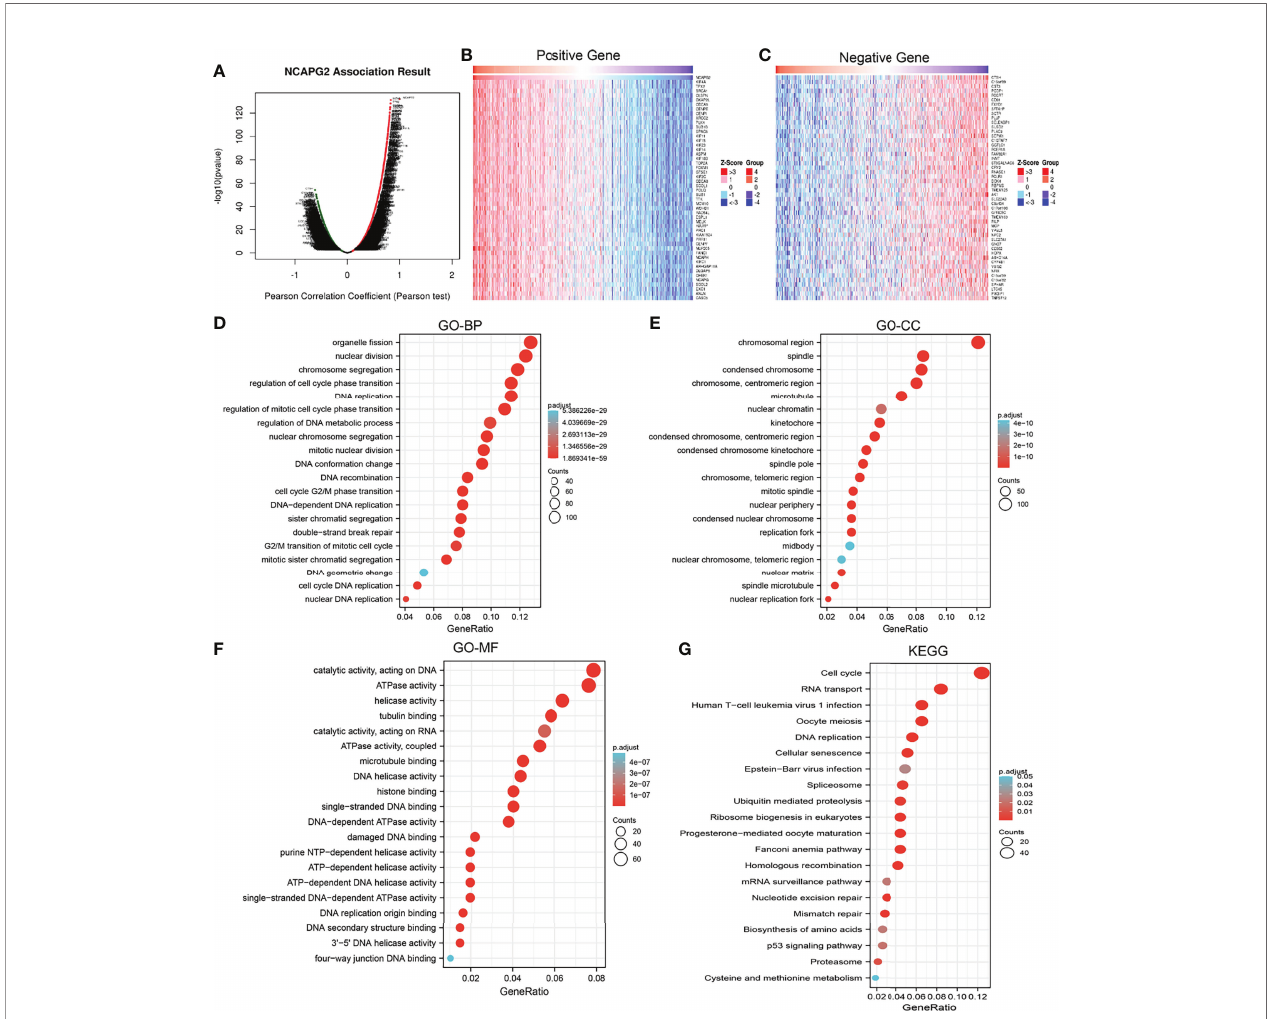
FIGURE 7 | Functional enrichment analysis of NCAPG2 in LUAD. (A – C) The correlation analysis of NCAPG2 expression and its top 100 co-expressed gene network. (D – G) GO and KEGG enrichment analysis of co-expressed